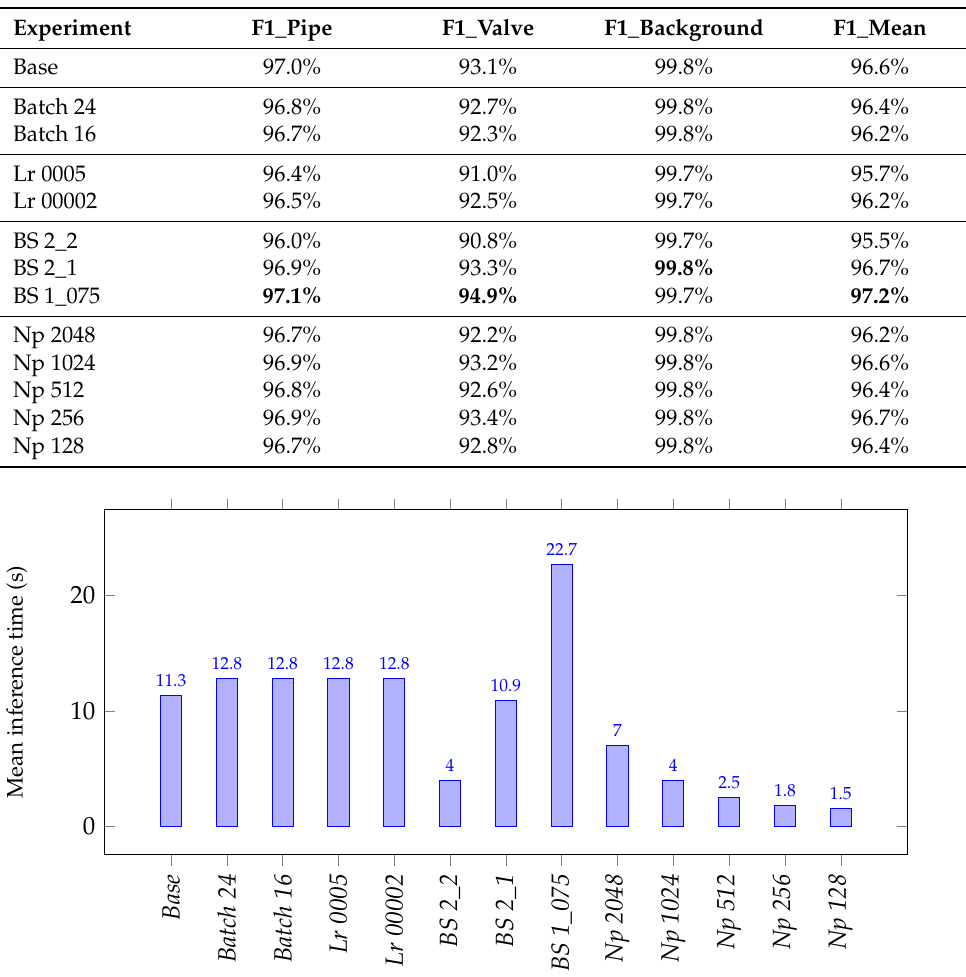
Figure 7. Pool test set mean inference